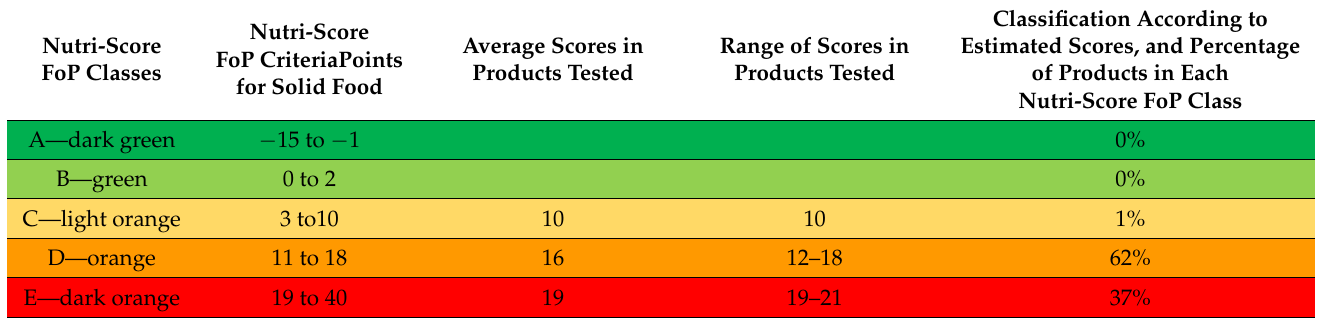
Table 4. Distribution of graviera cheese products in the different Nutri-Score classes.